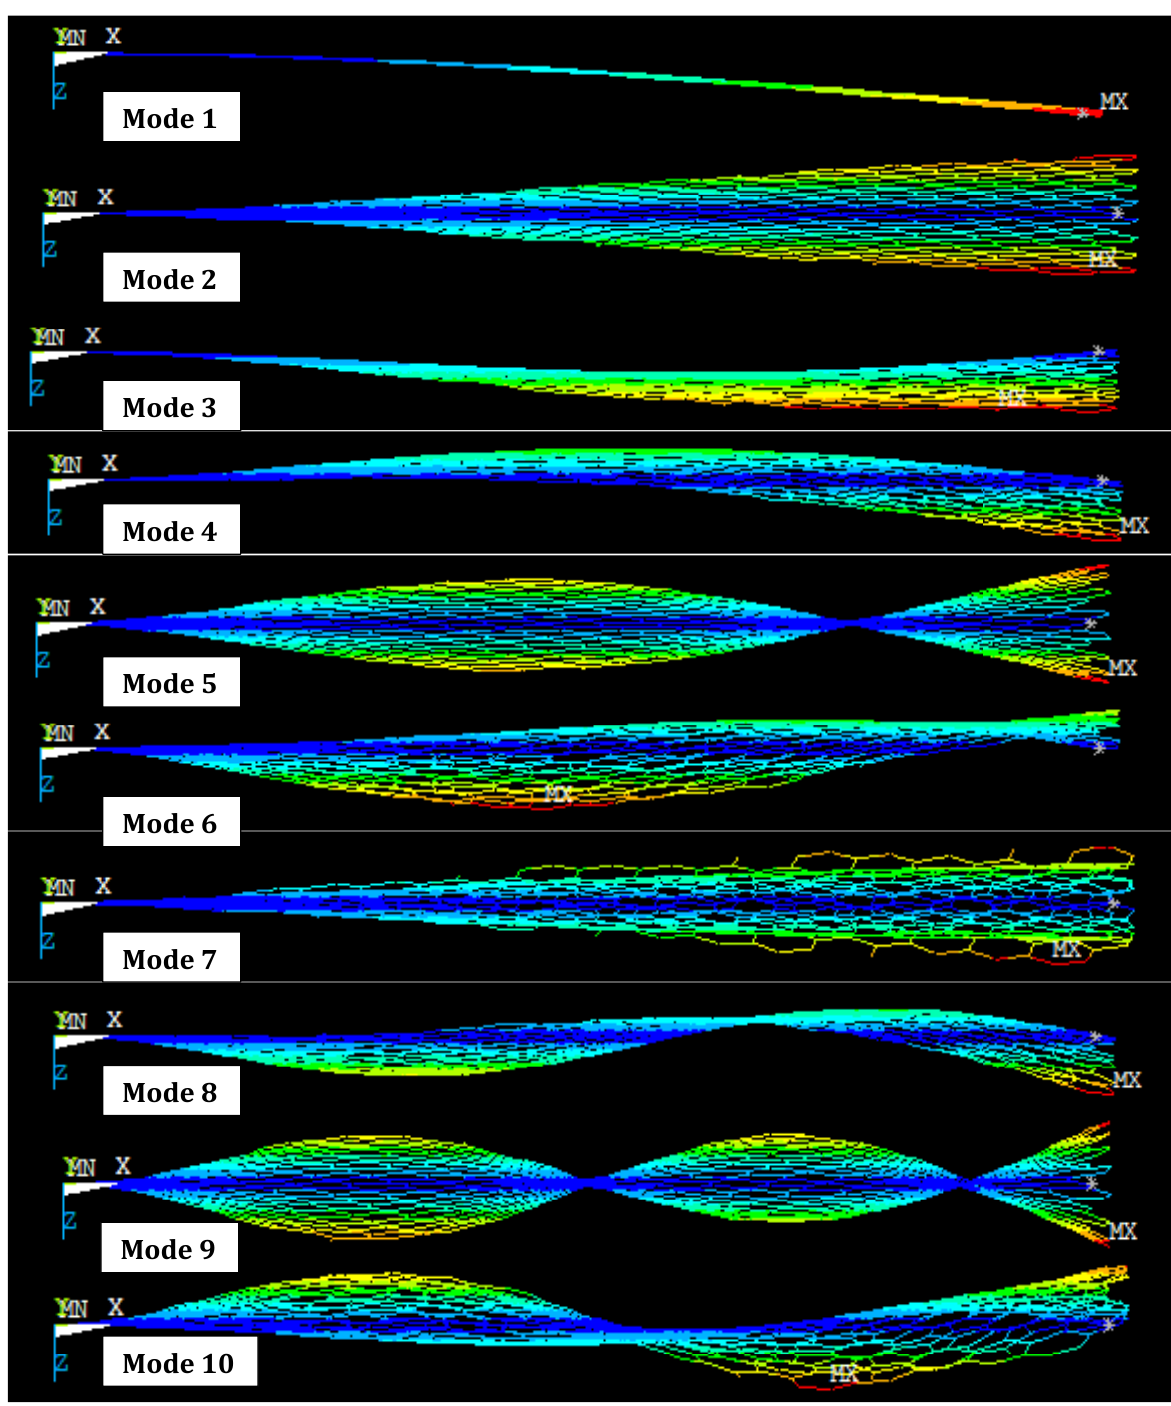
Figure 15. Different mode shapes of cantilever SLG (16, 4) with length 50 nm (front view of mode shape).